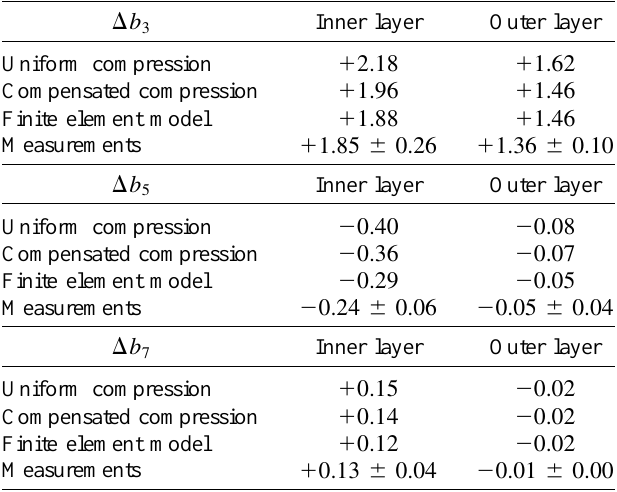
TABLE IV. Effect on an additional shim of 0.1 mm on allowed multiples ( 10 2 4 units, R ref (cid:1) 17 mm): experimental data and comparison with the finite element model and with the uniform azimuthal compression approximations.